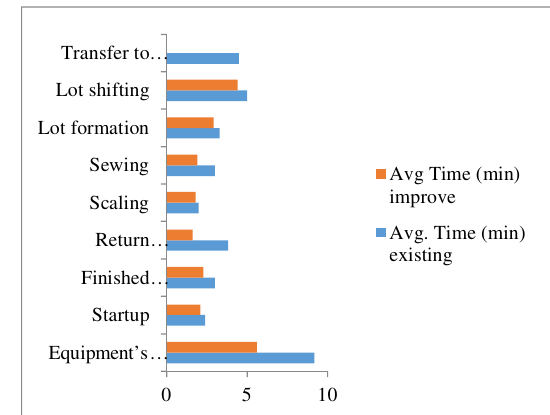
Fig. 4: Comparison of Existing and Improved